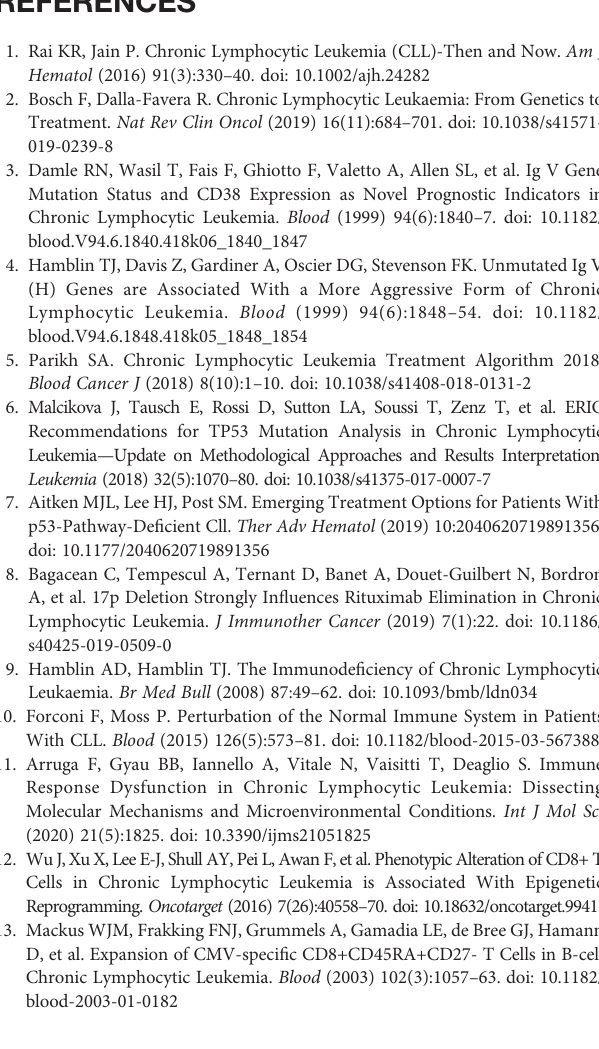
a gradient RMS (root mean square for image sharpness) histogram was used to gate for cells in focus (Focus). Third, the intensity of PE/Cy7 (CD56) was gated against the intensity of Emerald-Lifeact (EmLA). Double positive events were categorized as conjugates and used for subsequent image analysis. We de fi ned AR + CLL cells as target cells with an increased relative intensity of EmLA fl uorescence in the IS mask in relation to the total intensity of EmLA in target cells. For determination of granzyme B content in CLL cells, the NK cell part of the immune synapse is excluded from the analysis. (D) Immune synapse de fi nition using IDEAS. Cell shape de fi ned by surface labelling (CD56) or EmLA expression was extended by 3px in all dimensions using the dilate function. The overlapping region was de fi ned as the immune synapse mask (IS mask) in NK cell-CLL cell conjugates. Created with BioRender.com Supplementary Figure 2 | (A) Imaging fl ow cytometry analysis of total F-actin fl uorescent intensity in AR + and AR - HG-3, PGA-1, JVM-3, and MEC-1 cells. Differences between cell lines are the result of differences in transduction ef fi ciency and transgene expression. Analysis was performed using a Wilcoxon paired t-test.